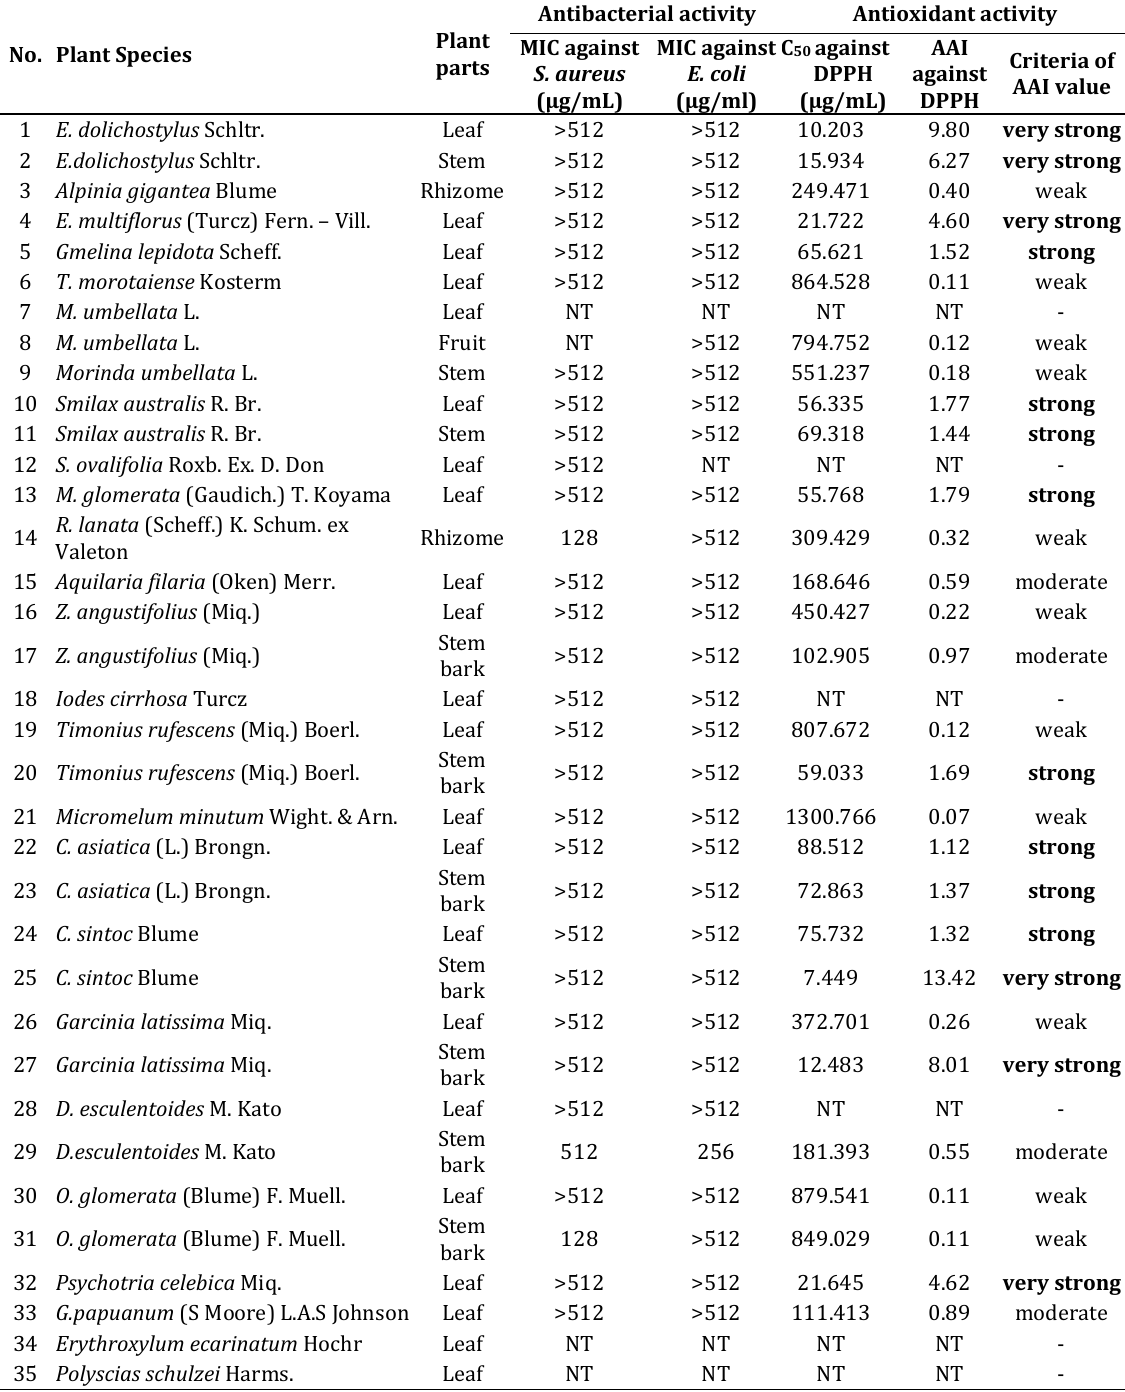
Tabel I. Antibacterial and antioxidant activities of Halmahera island plant extracts